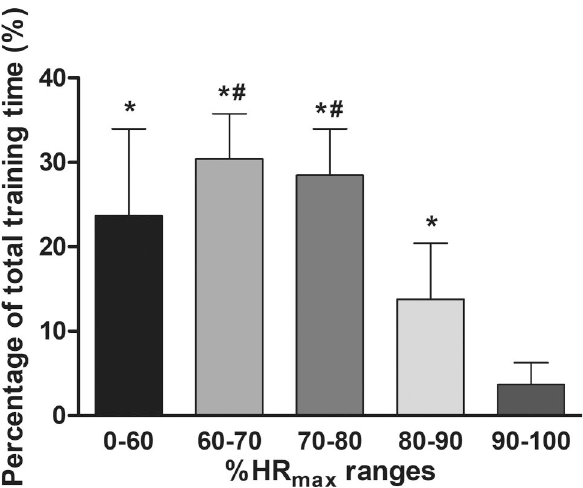
Figure 2 - Average time spent at five different exercise intensities, deter- mined by the maximum heart rate percentage, during gymnastic training sessions. HR max = maximum heart rate, *means significantly different from 90-100% HR max , #means significantly different from